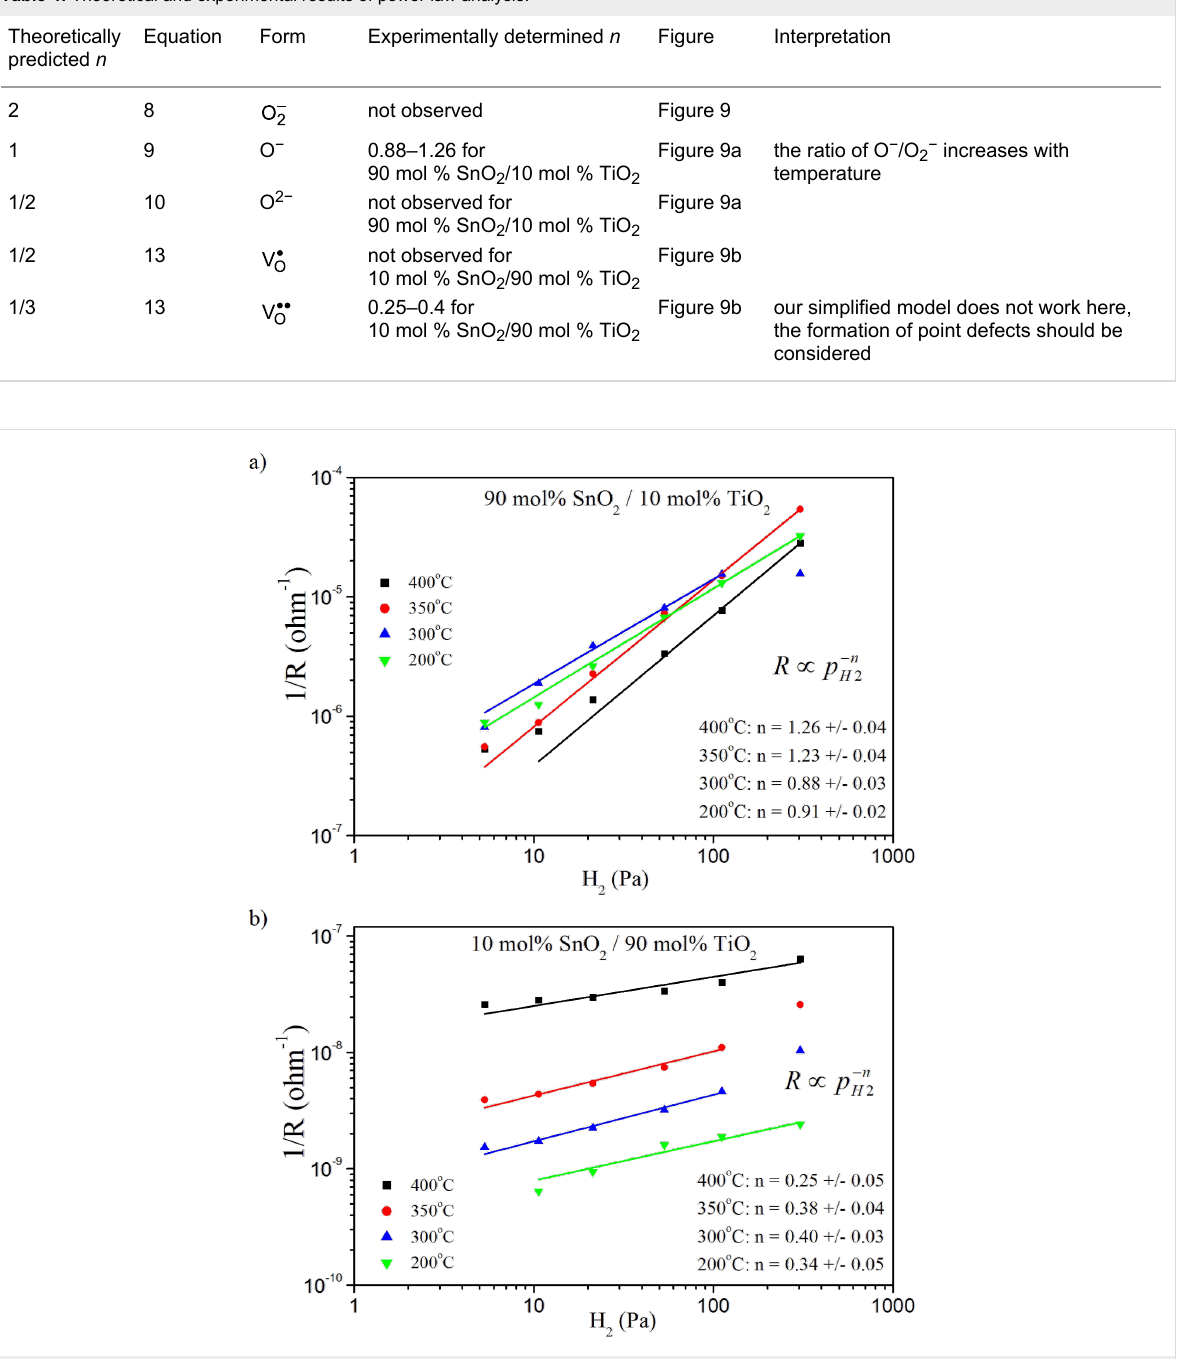
Figure 9: Log–log plot of the inverse of electrical resistance vs the hydrogen partial pressure for: a) 90 mol % SnO 2 /10 mol % TiO 2 and b) 10 mol % SnO 2 /90 mol % TiO 2 at temperatures of 200–400 °C.